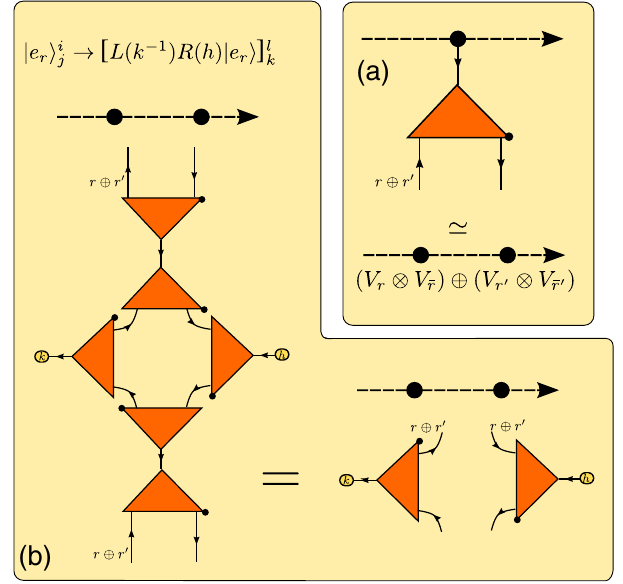
h Þ that generates the gauge trans- FIG. 13. The operator A s ð formations in the truncated KS LGT. It is the result of the FIG. 12. (a) The Hilbert space of a gauge boson in the truncated h Þ of Fig. 7 with W truncation of the operator A KS LGT is obtained by truncating C ð G Þ with the isometry W defined in T s ð T ⊗ ¯ V ⊕ ð V ⊗ ¯ V Eq. (28). On each link, the operator acts on the constituent closer defined in Eq. (28). It is isomorphic to ð V . r r Þ r 0 r 0 Þ h Þ or Γ h Þ , which is controlled by the to s through a rotation Γ Each term of the direct sum is a tensor product of two r ð r 0 ð constituents, so that we represent it by two solid circles on each irrep of the neighboring constituent on the same link. It thus link. (b) The operators implementing the left and right rotations performs controlled operations in between the two constituents of defined in Eqs. (29) and (30) are obtained from those of Fig. 6 a link, as suggested by a dot on the controller leg and by an arrow after conjugation with W that joins it with the controlled . T